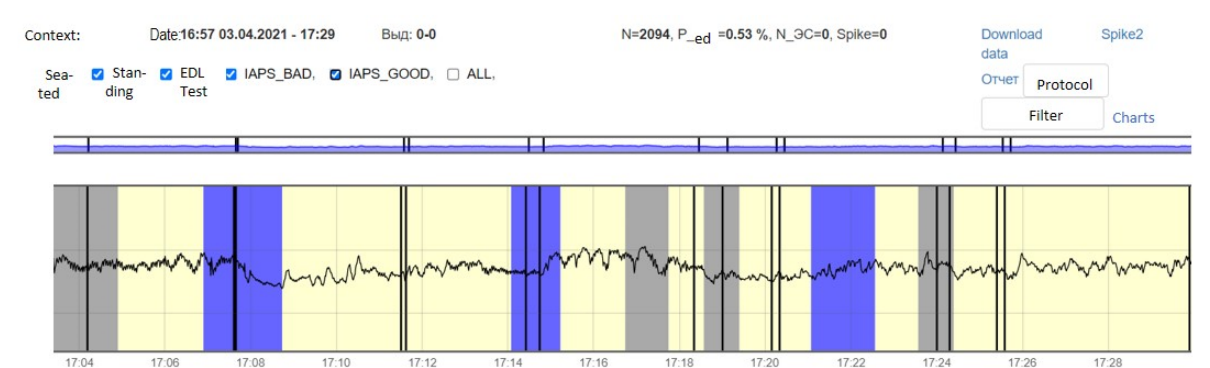
Figure 16. Inversion (optimization) case.